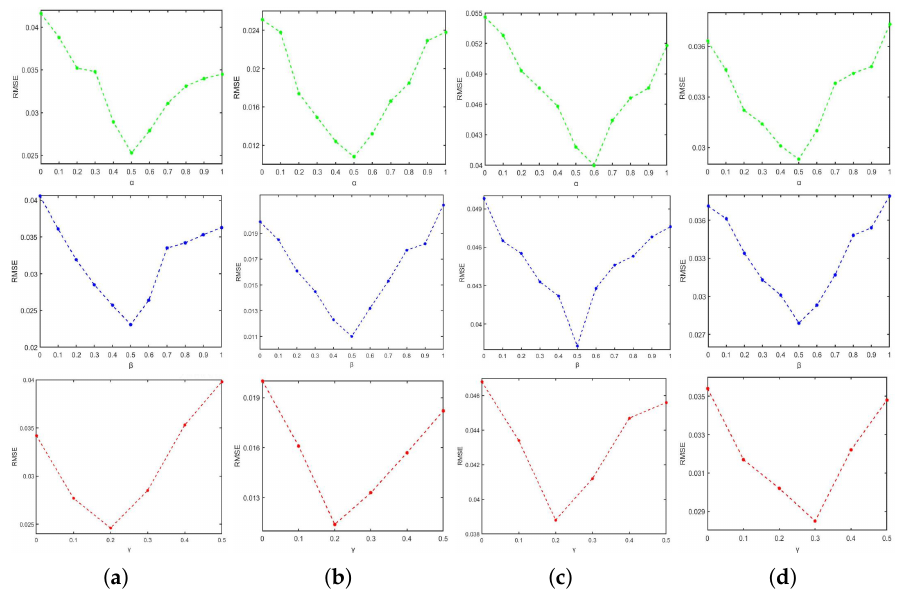
Figure 15. Parameter sensitivity analysis of the Wing loss function in four datasets. ( a ) Synthetic